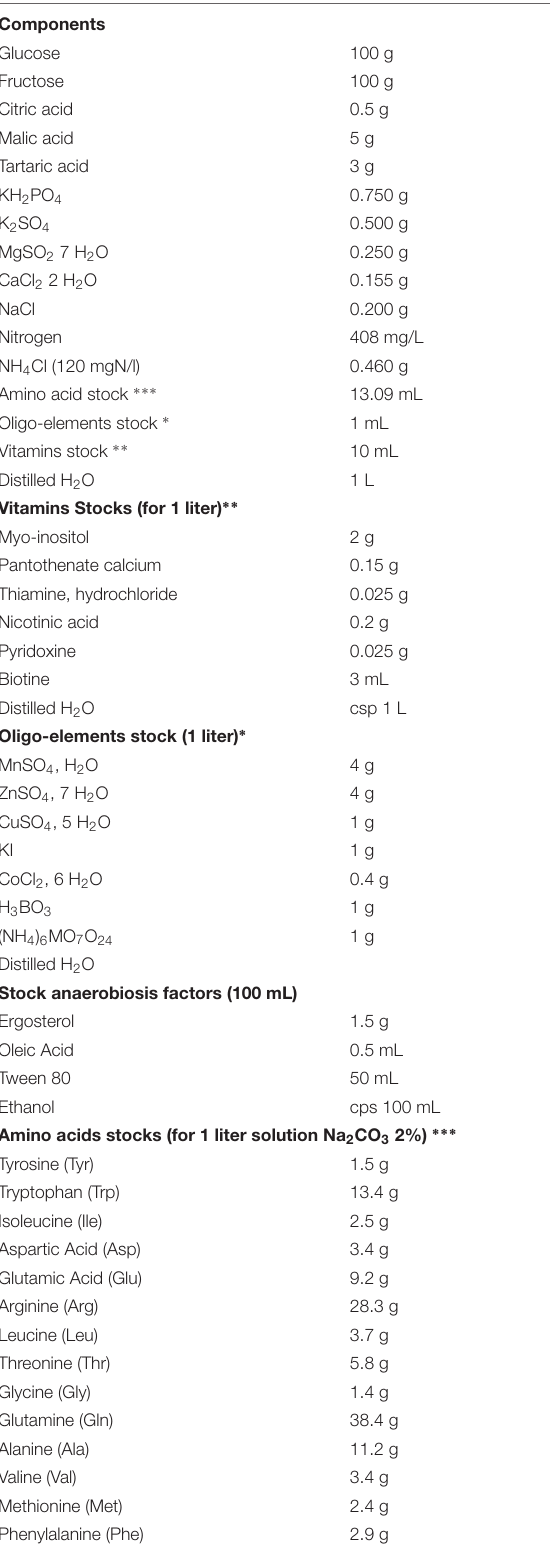
TABLE 3 | Synthetic must